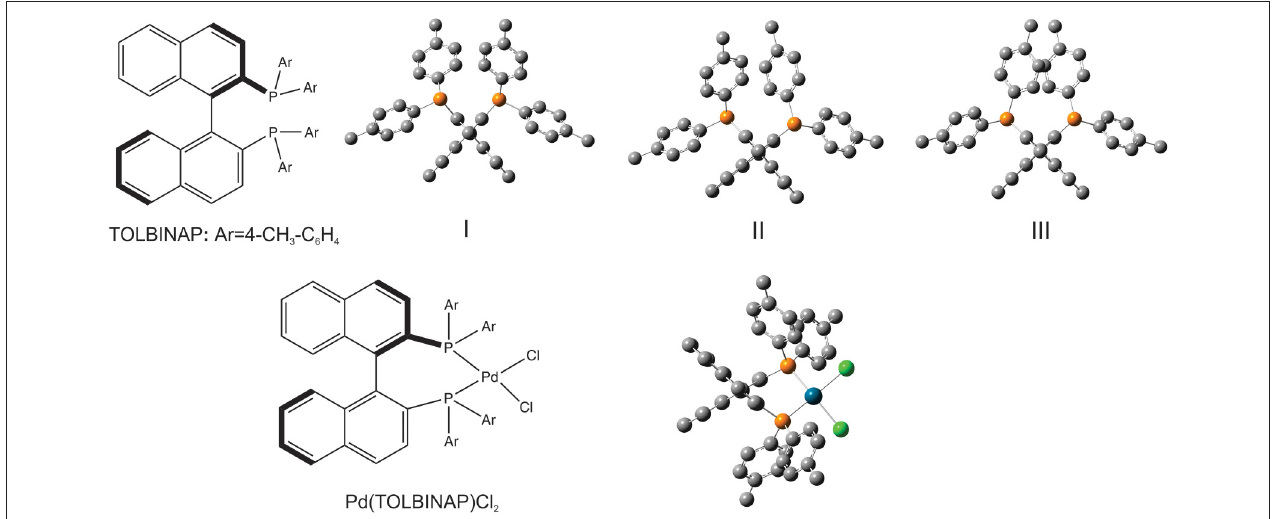
FIGURE 1 | Chemical formula of the ligand, TOLBINAP, and its Pd complex. Geometries of the three TOLBINAP conformers, I, II, and III, and the only dominant conformer of Pd(TOLBIANP)Cl 2 are also given. Reproduced with permission from Dezhahang et al. (2012). Copyright 2012, The Royal Society of Chemistry.